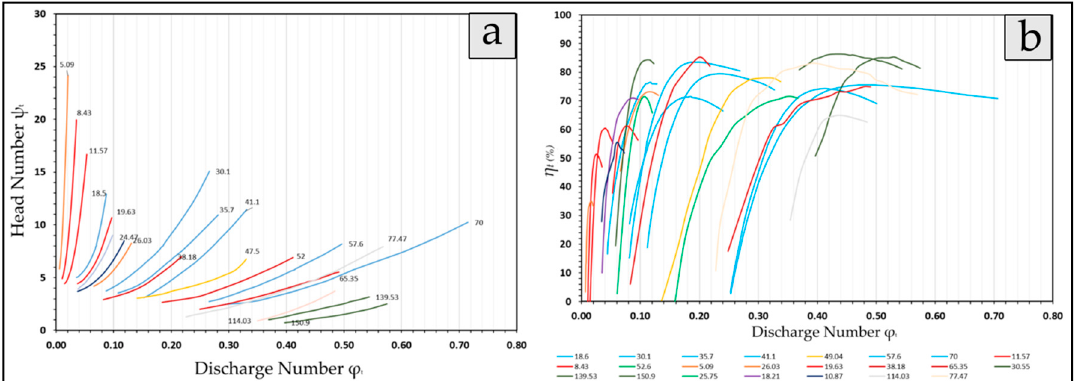
Figure 3. ( a ) Non-dimensional numbers of discharge and head as a function of the specific speed. ( b ) Non-dimensional number of discharges as a function of the specific speed.